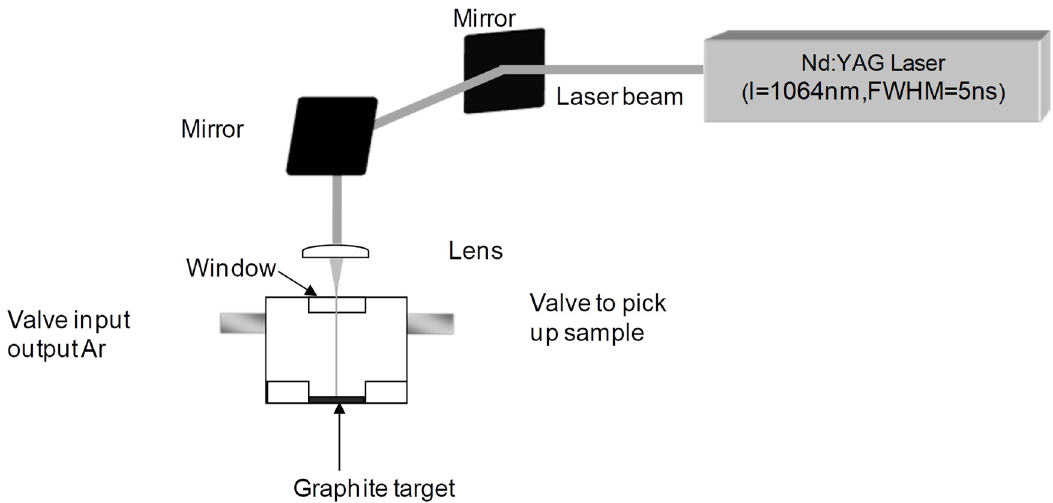
Figure 2. Setup of the laser apparatus and reactor. The reactor was evacuated to a pressure of 10 − 2 mbar and flooded with argon. The process was repeated several times to make the chamber as oxygen-free as possible.